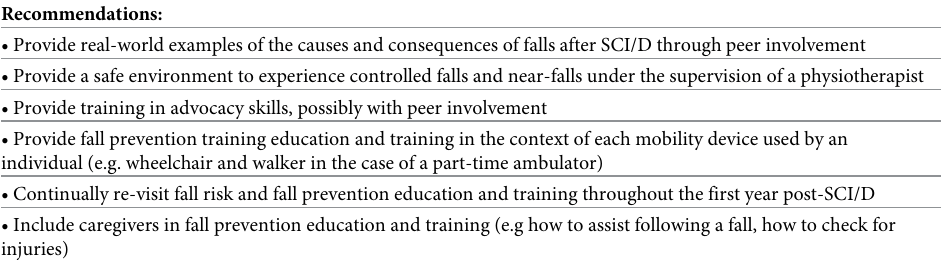
Table 3. Recommendations for fall prevention education and training in the first year post-SCI/D.